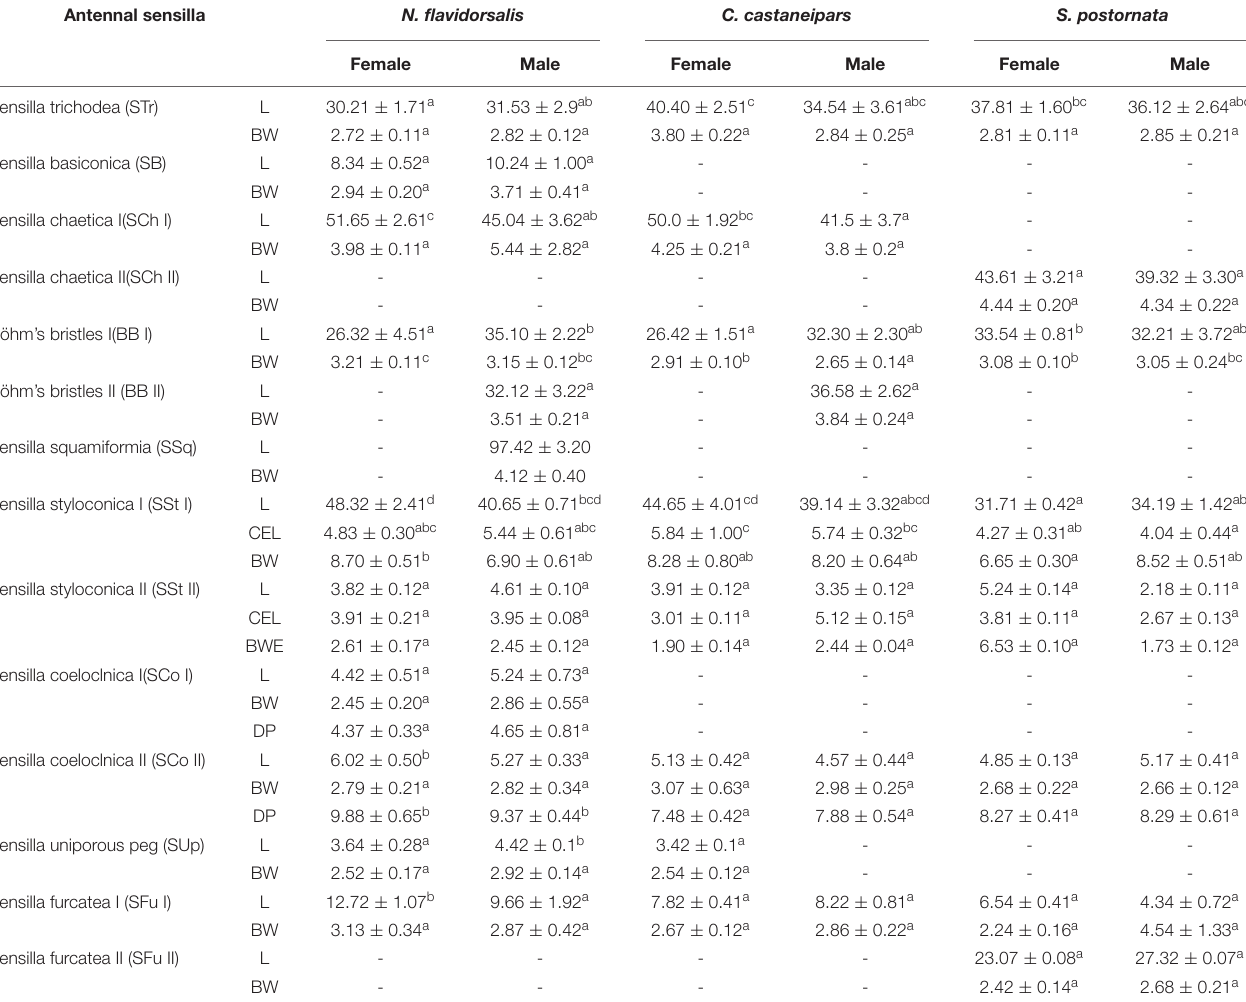
TABLE 4 | Morphological measurements of different types of antennal sensilla in three species of Limacodidae (Mean ± SE) ( N = 20). Antennal